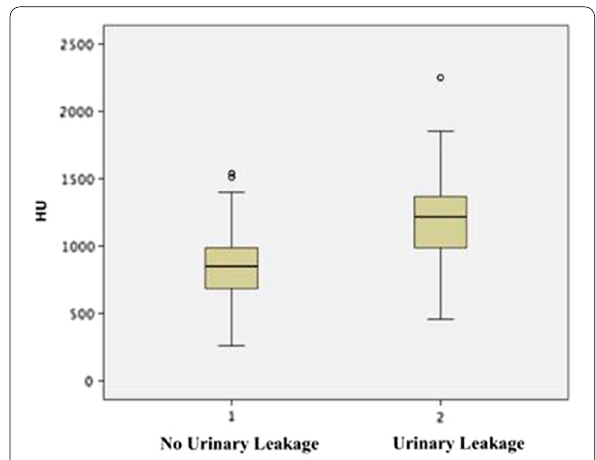
Fig. 1 Box plot of HU values according to urinary leakage status